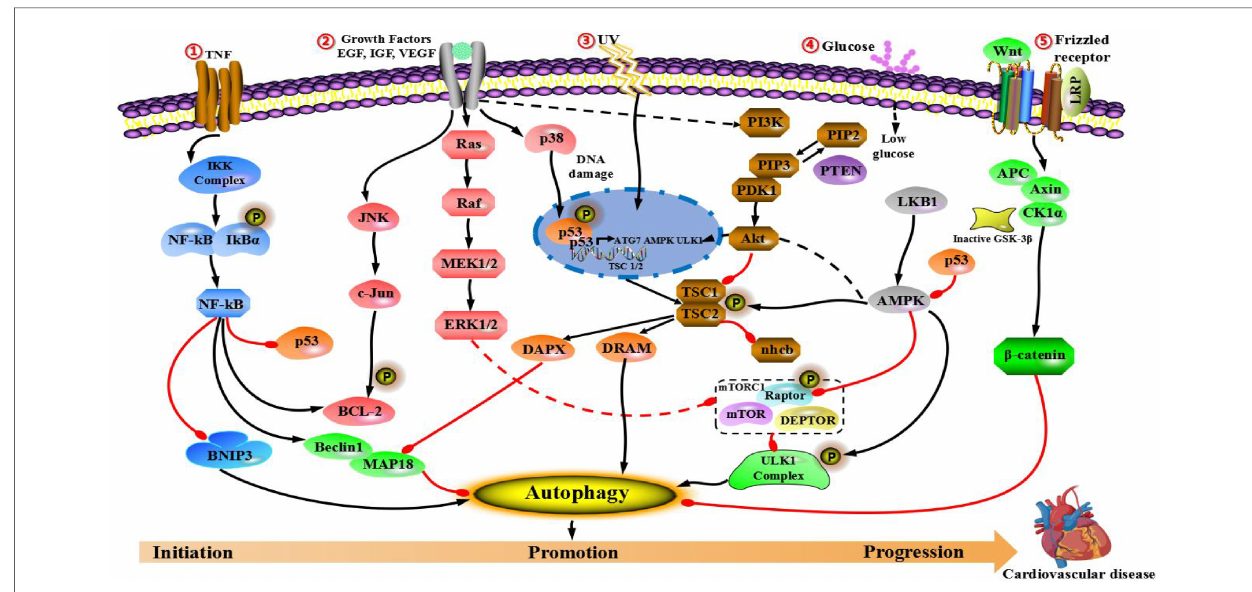
FIGURE 4 Regulation of cross- interference between autophagy and main signaling pathways in cardiovascular disease. (1) NF- κ B pathway of IKK α / β and NF- κ B induces autophagy by increasing the expression levels of autophagy-related proteins, such as Beclin-1. (2) Growth factors (including EGF, IGF and VEGF) promote autophagy by modulating the autophagic process of JNK/c-Jun, Ras/Raf/MEK/ERK and the PI3K/Akt. (3) p53 pathway: Autophagy is also mediated by the nuclear p53 activity, which is a transcribed factor under stressful conditions (such as ultraviolet rays, etc.). p53 induces the classic autophagic pathway mainly through PI3K/Akt/mTOR, AMPK/mTOR and ULK1 complex. (4) PI3K/Akt/mTOR and AMPK/mTOR receptor tyrosine kinases promote the transformation of PIP2 into PIP3 and the activation of PI3K. PTEN-induced dephosphorylation of PIP3 activates the AKT signal negatively regulated by PI3K. Amino acids and nutrient-rich conditions can initiate the activity of mTORC1 signal. By contrast, starvation and oxidative stress can inhibit the activity of mTORC1 signal and induce autophagy. (5) Wnt- β -catenin pathway: This pathway causes the activation and nuclear recruitment of β -catenin protein, so as to directly regulating